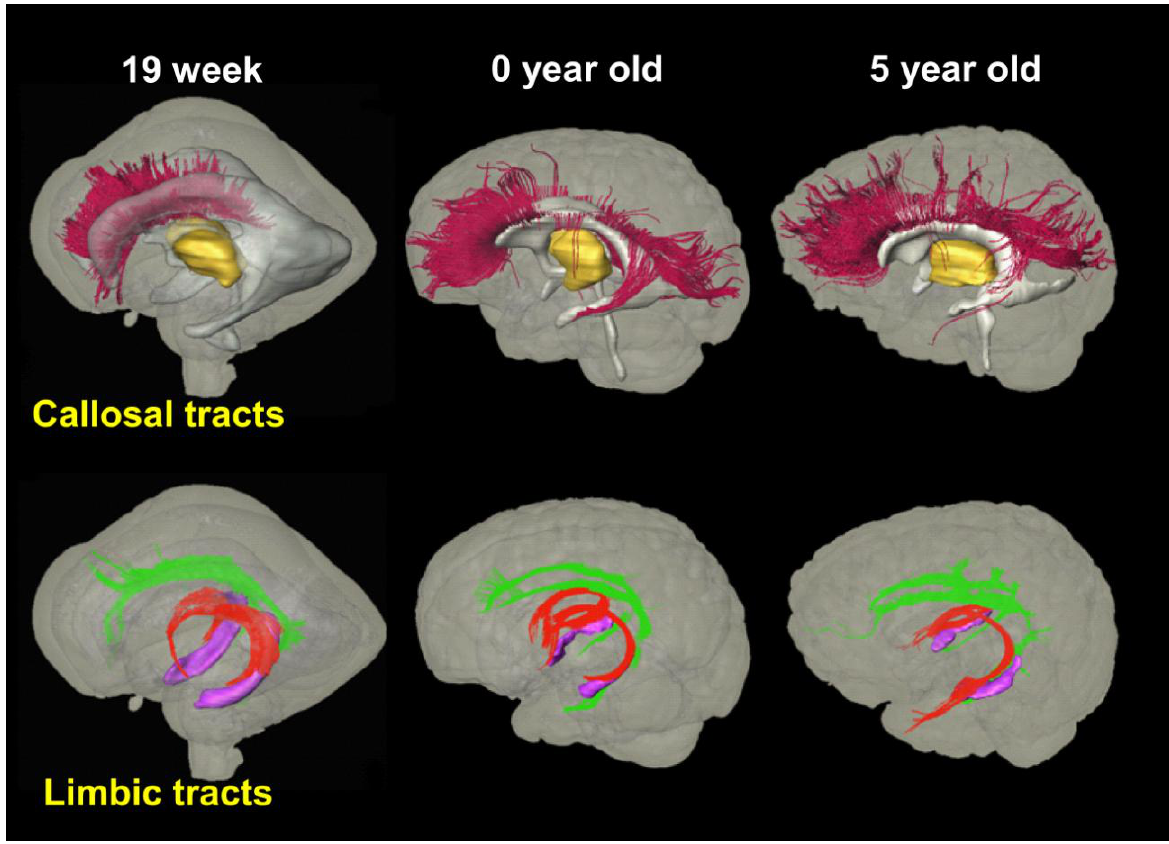
FIGURE 3. Upper row shows the three-dimensional tractography of corpus callosum for 19-gestational-week fetal brain, neonatal brain, and pediatric brain, respectively. The corpus callosum is not well developed in the posterior portion in the 19-week fetal brain. Lower row shows the three-dimensional reconstruction of the white matter tracts of the limbic system of the brain at the correspondent ages. In the lower row, the fornix (fx, red) and cingulum (cg, green) are reconstructed. The purple structure is the